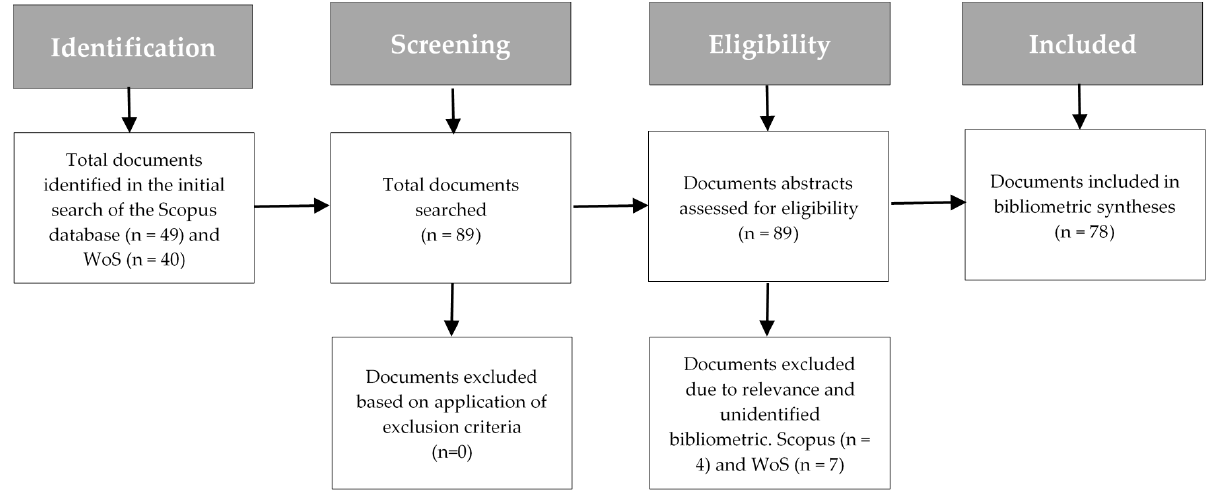
Figure 1. Preferred Reporting Items for Systematic Reviews and Meta-Analyses (PRISMA) method procedure that details the steps in the identification and selection of documentary units.